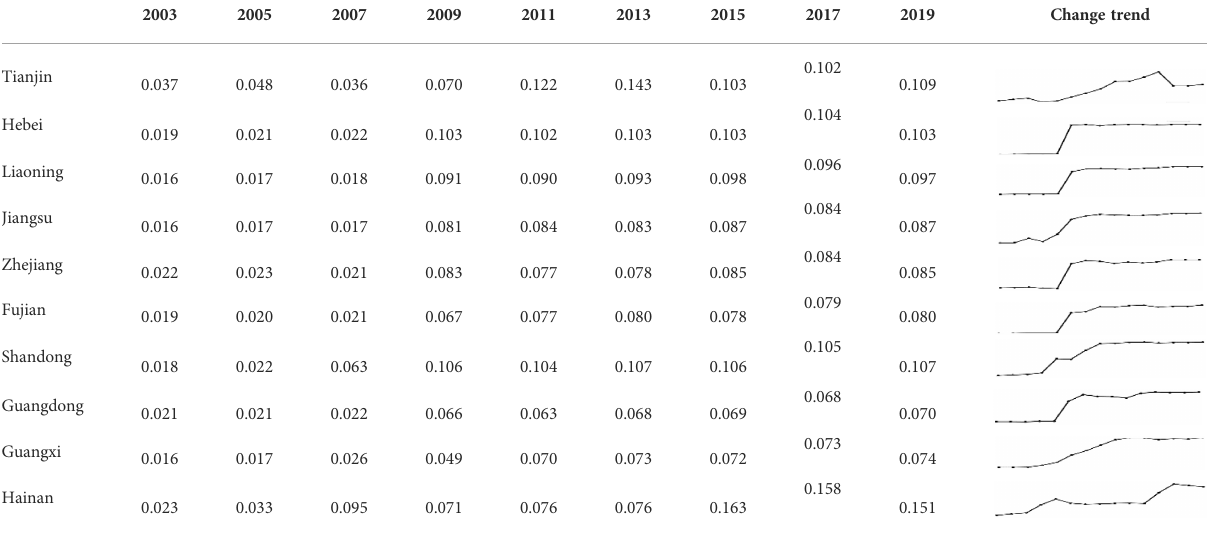
TABLE 3 Upgrading index of production structure of China ’ s marine fi shery